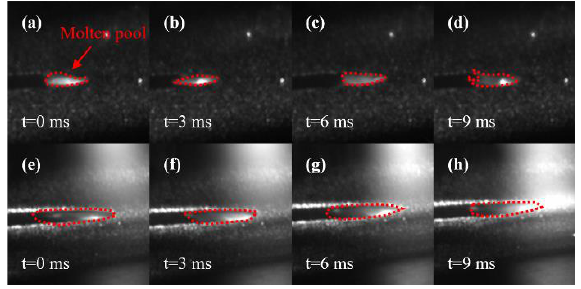
Figure 4. Dynamic process under different welding modes: ( a – d ) LW 600; ( e – h ) HLAW 600-20.